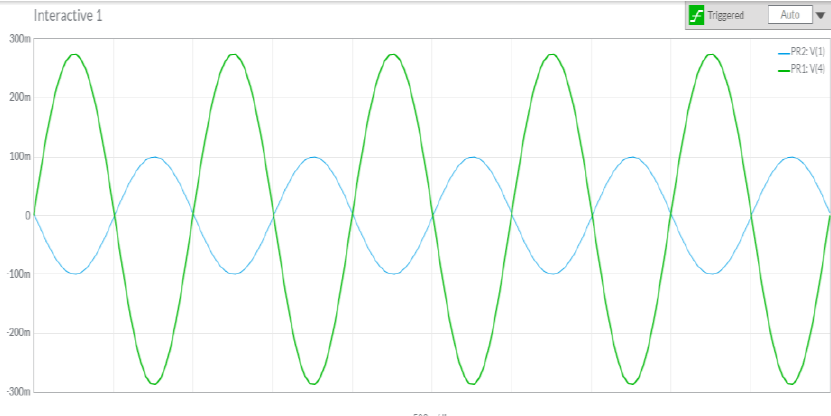
Figure 7. Initial testing driver circuit for TIP31C.